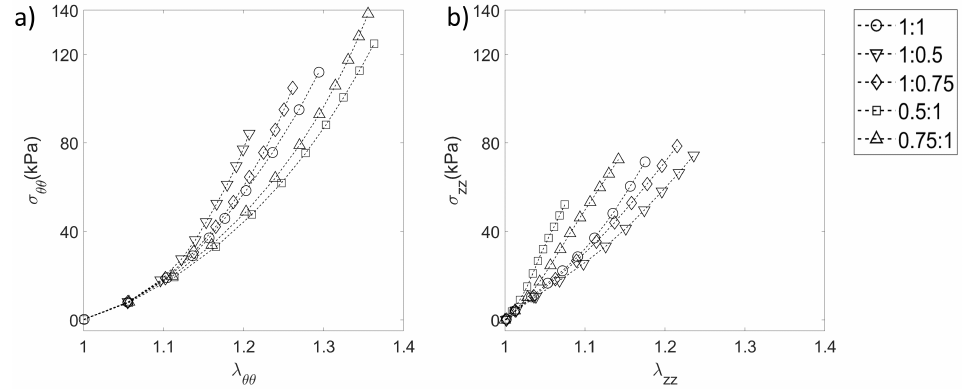
Figure 9. Mechanical stress stretch curves resulting from the test case for circumferential ( a ) and longitudinal ( b ) test directions.